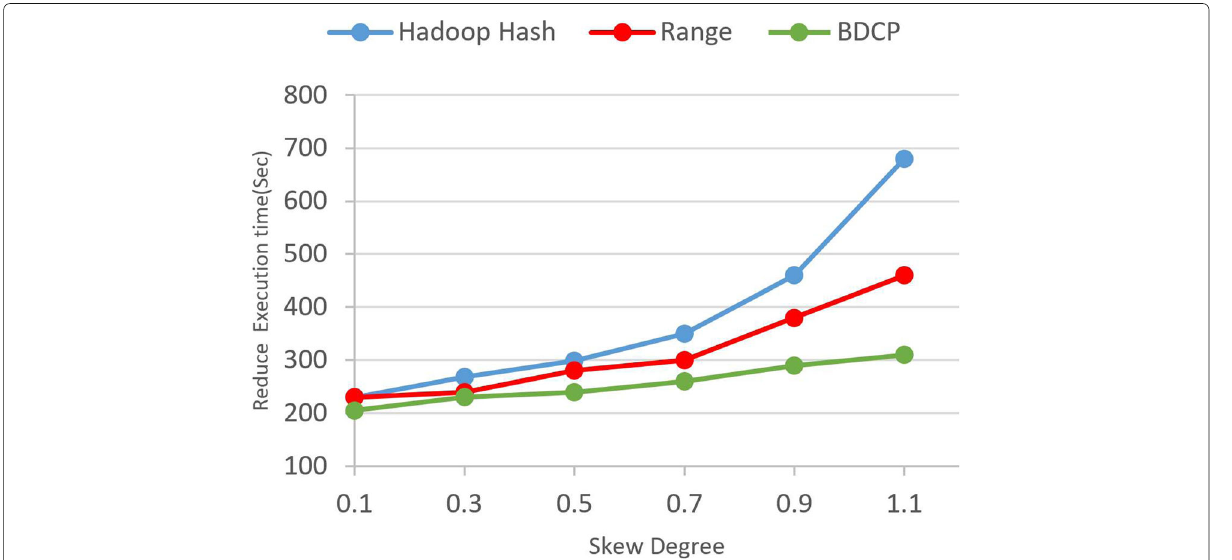
Fig. 10 Sort job on a file of size 6 GB, and 0.1 to 1.1 skew degree